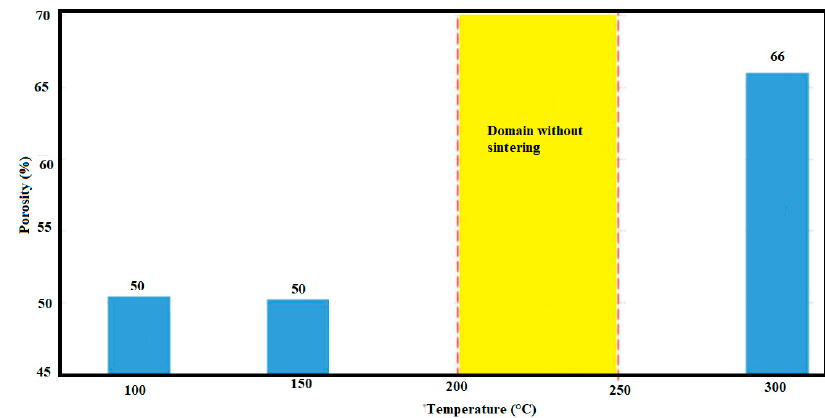
Figure 7. Porosity as a function of temperature in hydrothermal sintering.